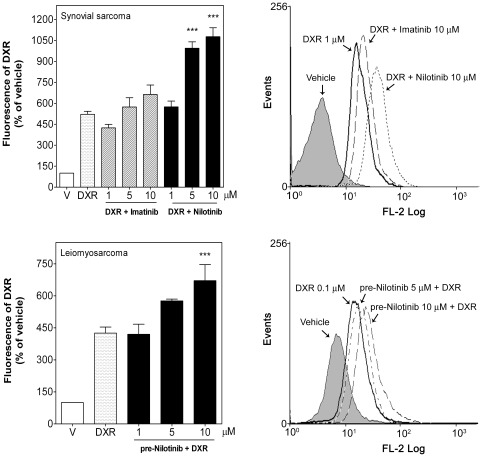
Nilotinib, but not imatinib, increased intracellular doxorubicin in human STS cells.Synovial sarcoma SW982 and leiomyosarcoma SK-UT-1 cells were incubated with vehicle (DMSO) or DXR (1 µM) in the absence (vehicle, V) or presence of nilotinib (1–10 µM) or imatinib (1–10 µM) as described in the Material and Methods section. After 24 h incubation, intracellular DXR was measured by its fluorescence intensity with flow cytometry. Left, Median of intracellular DXR fluorescence in the absence (V) or presence of TK inhibitors normalized to vehicle-treated cells (taken as 100%). Each column represents mean ± SEM of seven independent experiments. Right, Representative flow cytometry analysis of the intracellular DXR fluorescence detected with excitation at 488 nm and emission at 580 nm in both cell lines. ***
P<0.001 versus DXR-treated cells.